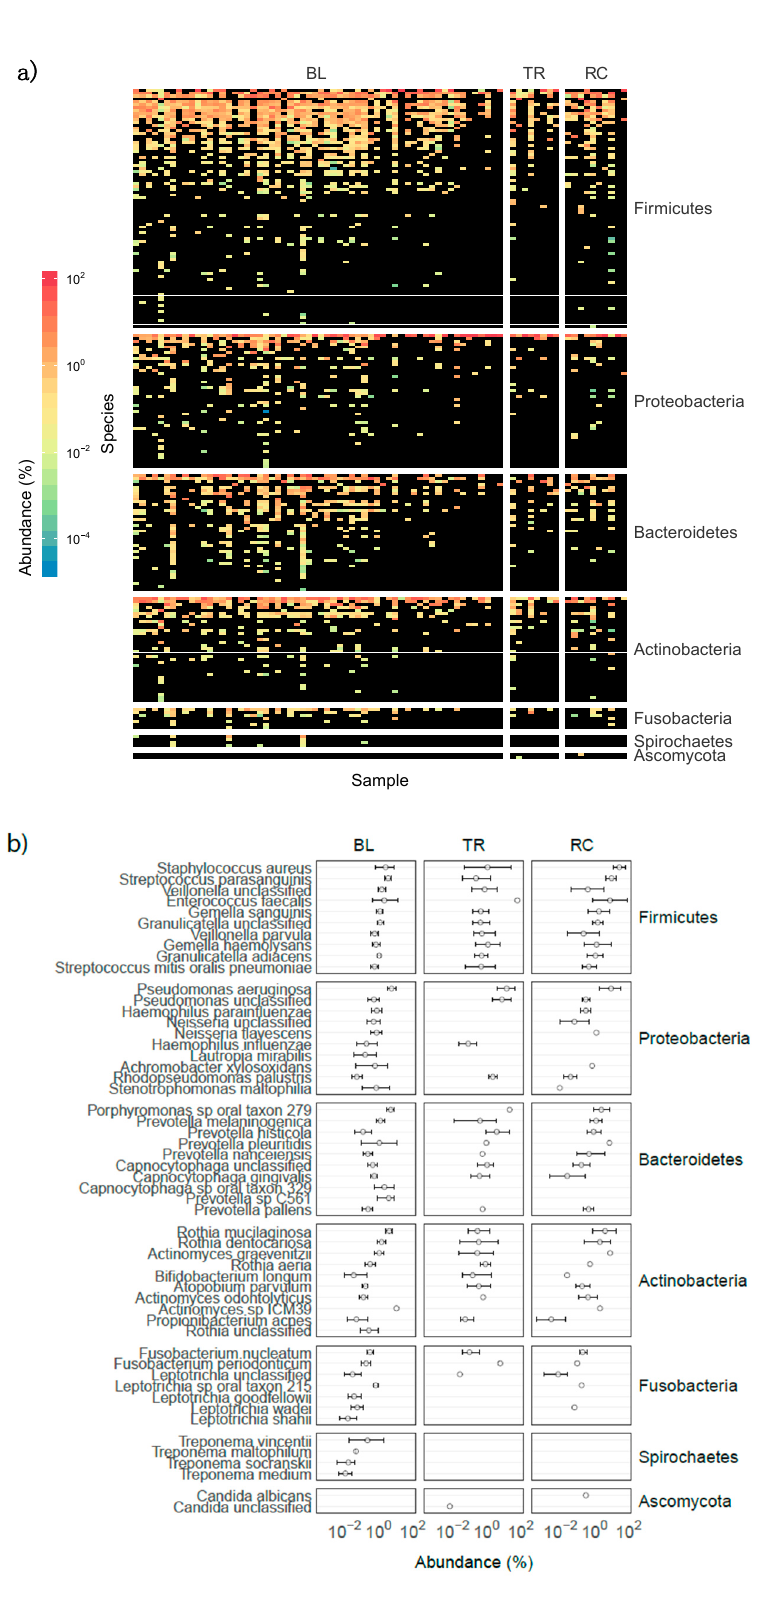
Figure 1. Taxonomic distribution in patients enrolled in the study. ( a ) The taxonomic distribution of all species detected using MetaPhlAn2 was reported in each row of the matrix whereas columns represent samples collected during the study. Colors from dark blue to red were used to report “copies per million” (CPM) values as obtained from HUMAnN2 with black reporting a CPM value of zero. The plot was divided according to patient status: BL, baseline; TR, treatment; RC, recovery.